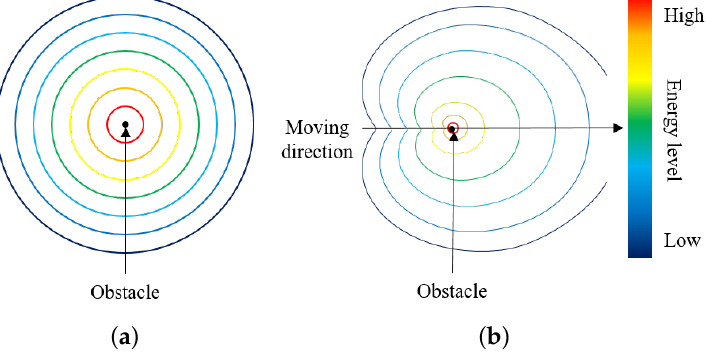
Figure 4. Aspects of dynamic characteristic potential field method: the potential field changes the distribution according to the moving direction of obstacle. ( a ) if the obstacle is not moving, the potential field is generated as the uniform distribution. Conversely, ( b ) if the obstacle is moving, the potential field is drifted to the moving